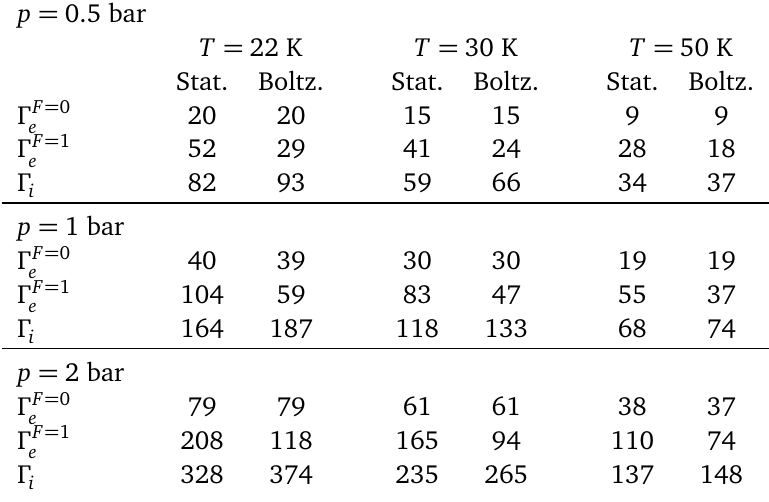
target pressures ( p ) and tem- 2 are considered: statistical 2